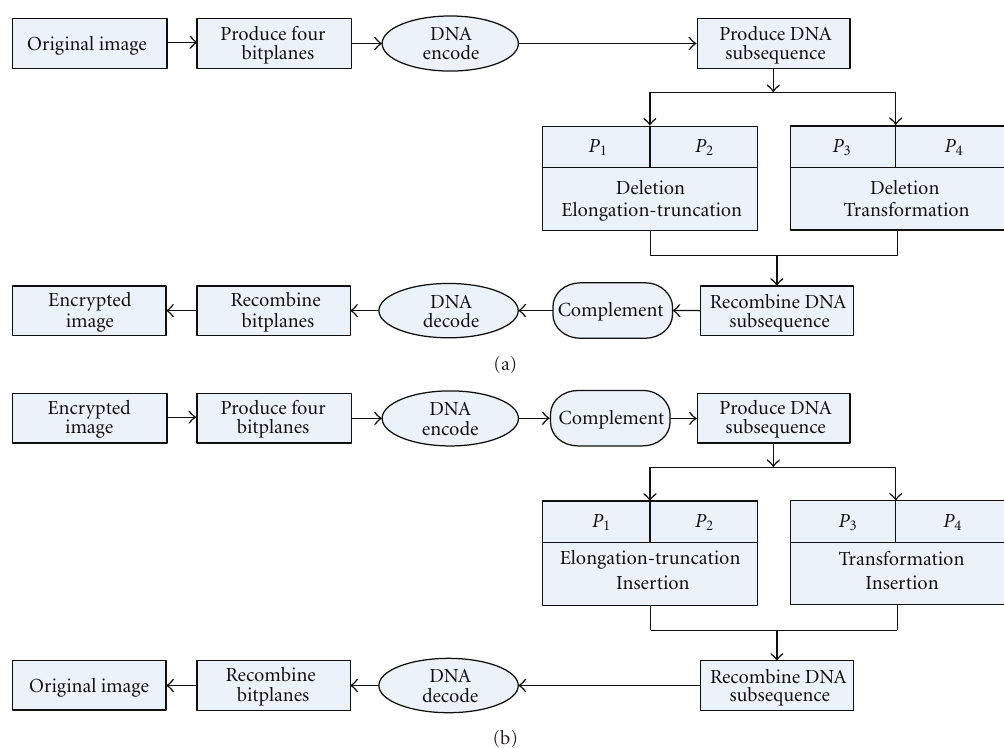
Figure 2: The block diagram of the proposed algorithm. (a) The block diagram of the encryption algorithm. (b) The block diagram of the decryption